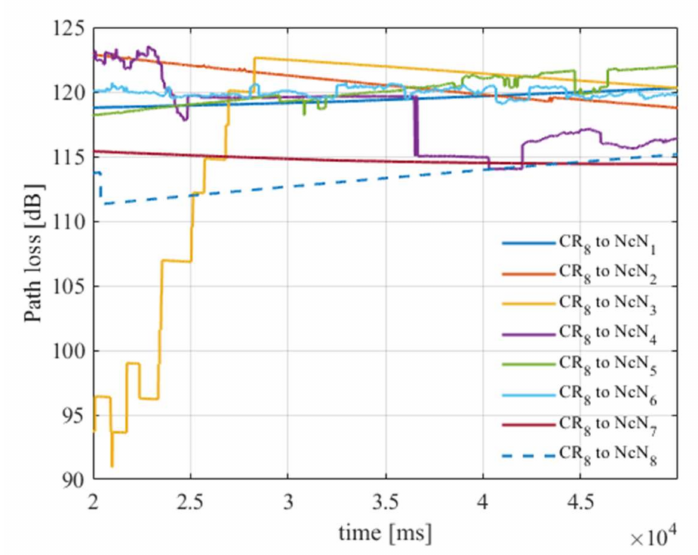
Figure 8. Path loss for Cognitive Radio node 8 and all NcNs from 20 s to 50 s simulation time for scenario 1.